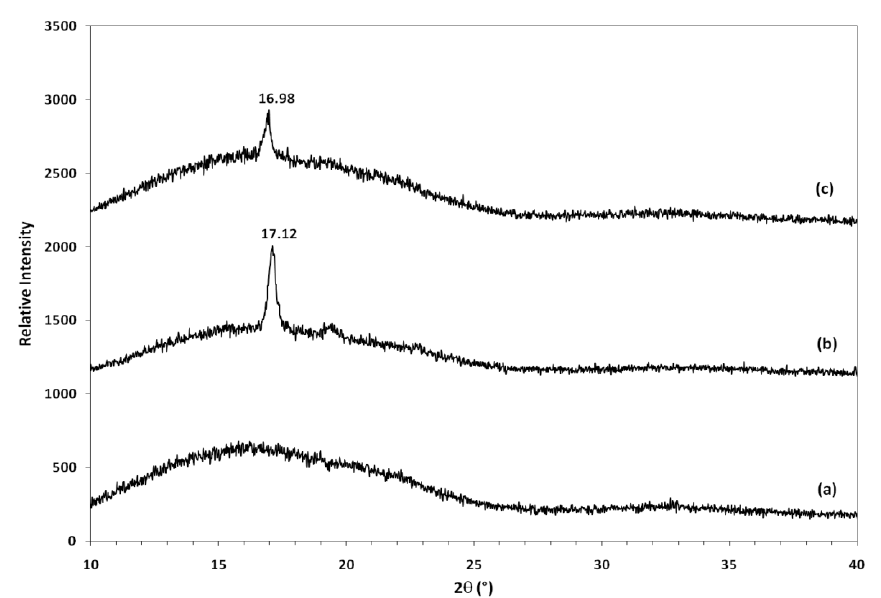
Figure 14. XRD of ( a ) neat PLA, ( b ) PLA/1 wt% EPO and ( c ) PLA/5 wt% EPO